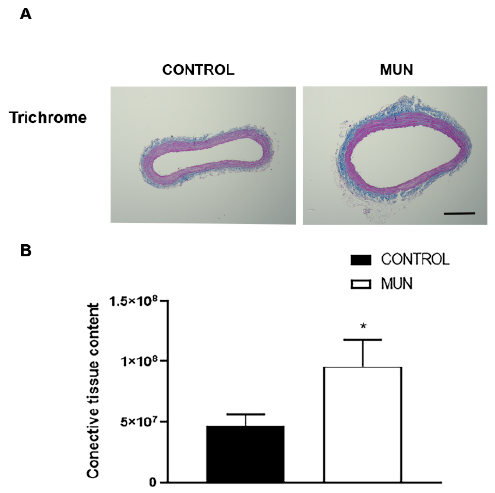
Figure 5. Influence of fetal undernutrition on the perivascular content of connective tissue in 6-month-old male offspring from rats exposed to maternal undernutrition during pregnancy (MUN) and rats fed ad libitum (CONTROL). ( A ) Representative images of mesenteric arteries from CONTROL and MUN. ( B ) Quantification data on the content of connective tissue. Results are expressed as a percentage of the total artery area. Images were obtained from Masson’s trichrome stained arteries (scare bar = 300 µ m). Values are mean ± s.e.m. from 6 rats in each group. Significant differences from the respective control rat: * p < 0.05.